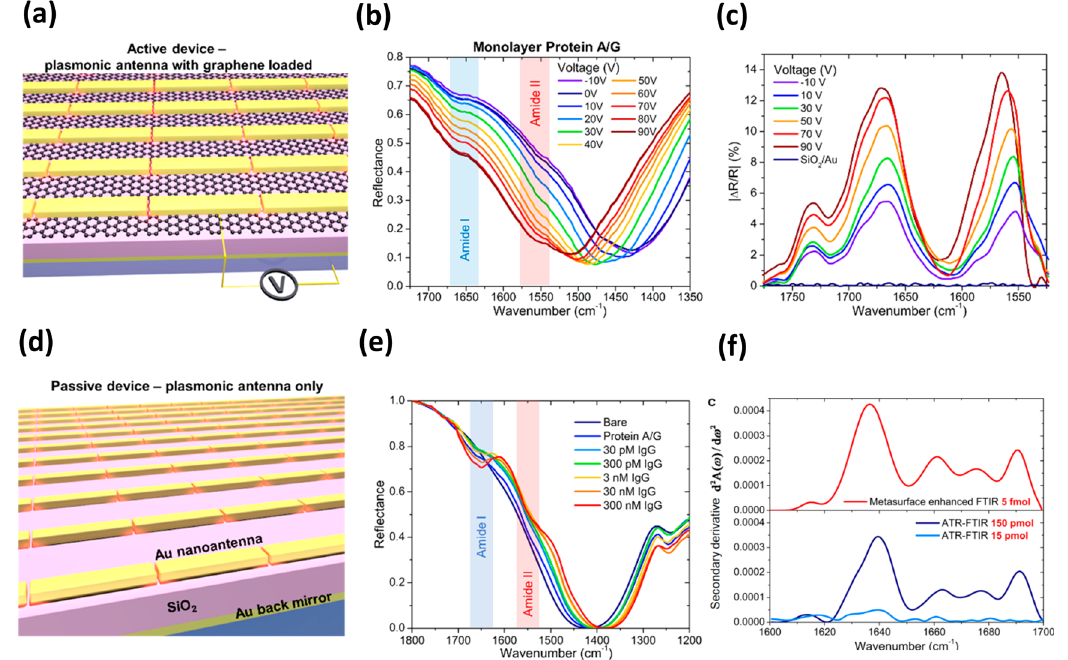
Figure 4: A tunable metasurface biosensor consisting of a gold nanoantenna array and a graphene layer for IgG antibodies detection. (a) Schematic of the active metasurface sensor with a graphene tunable layer. The Fermi level is tuned by an applied gate voltage. (b) ReflectancespectraforthemeasurementoftheproteinA/Gmonolayeratdifferentgatevoltages.(c)RelativeabsorptionspectraoftheamideI and II bandsof the protein A/G monolayer at various voltages. (d) Schematicof the passive metasurface sensor. Gold nanorod antennaswere fabricated on the 400 nm SiO 2 thin fi lm and a gold back mirror, while the gap between each nanorod antennas is 30 nm. (e) Measured re fl ectance spectra for the protein A/G monolayer and the molecular binding with different concentrations of IgG antibodies. (f) Surface- enhanced Fourier transform infrared (FTIR) measurement for IgG molecules. The measurement results show that it can provide four orders of magnitude improvement in the detection sensitivity compared to conventional attenuated total re fl ection FTIR method. (a) – (f) Reproduced with permission from Li et al., ACS Photonics 6 , 501 – 509 (2019) [129]. Copyright 2019 American Chemical